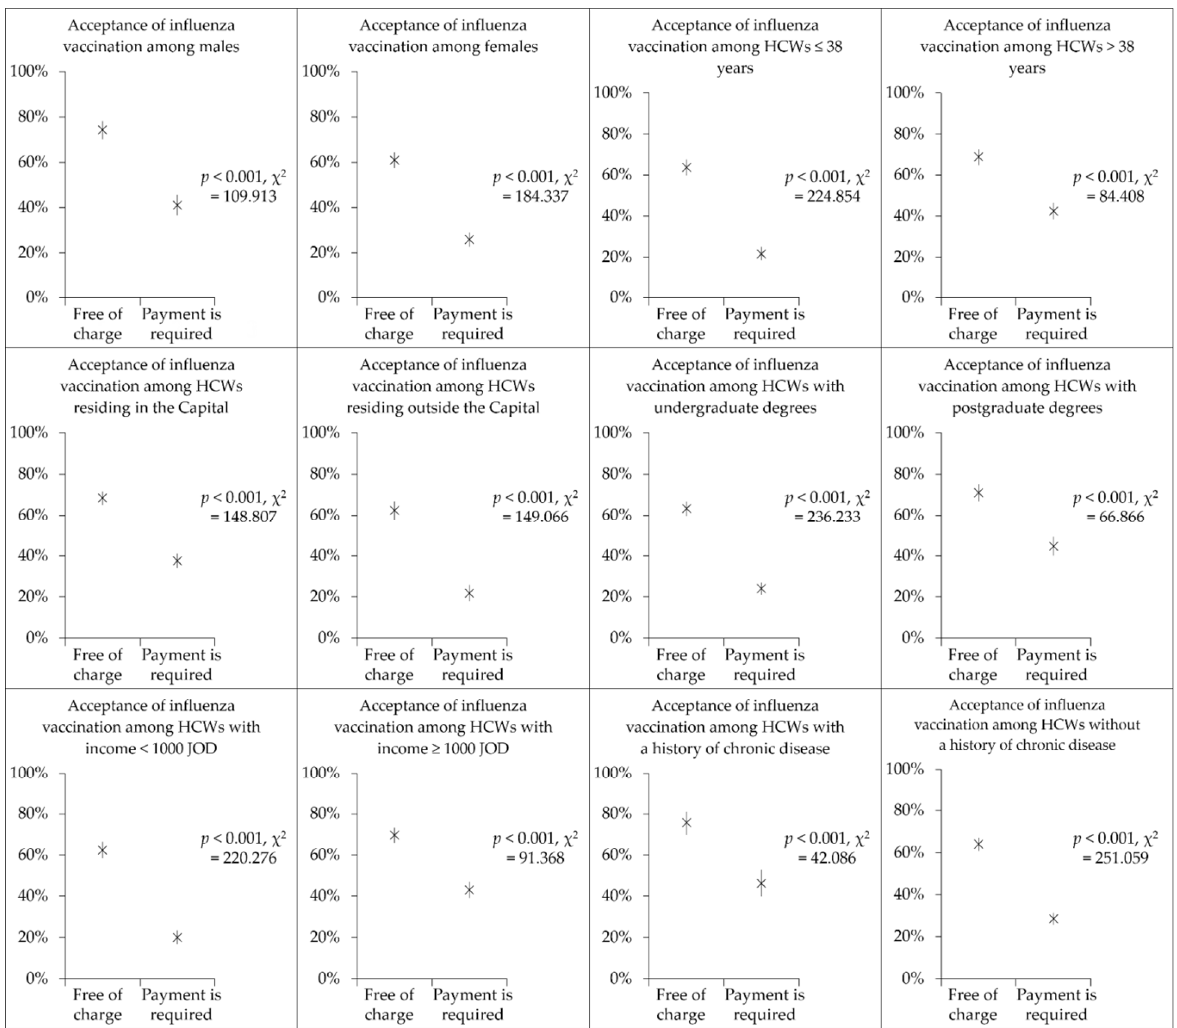
Figure 2. The decline in influenza vaccine acceptance if payment is required compared to acceptance of free vaccination stratified according to healthcare workers (HCW) variables. JOD: Jordanian dinar. × symbols represent the mean estimate of vaccine acceptance per variable, whereas the lines represent the 95% confidence intervals of the estimates.